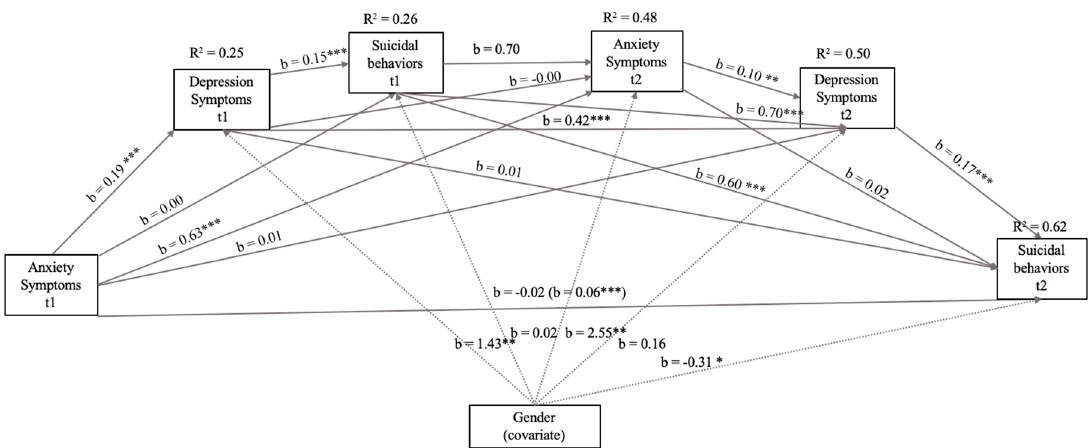
Figure 3. Model of mediation of the relations between Symptoms of Anxiety (t1 and t2), Symptoms of Depression (t1 and t2), and Suicide Behaviors (t1) with Suicide Behaviors (t2) after controlling for gender (girl). In this statistical diagram, values are represented with non-standardized regression coefficients. In the association between Anxiety Symptoms t1 and Suicide Behaviors t2, the value outside parentheses represents the direct effect and the value in parentheses represents the total effect of the bootstrapping analysis of Anxiety Symptoms t1 on Suicide Behaviors t2 after the inclusion of the mediating variables. *** p < 0.001, ** p < 0.01, * p < 0.05.